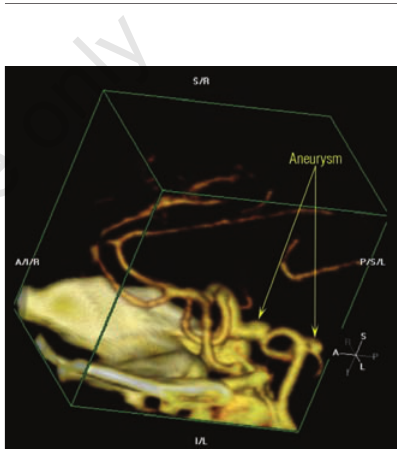
Figure 6. Computed tomography angiog- raphy showing a 6 x 4 mm aneurysm at the right posterior communicating artery and an 8 x 8 mm aneurysm arising from the distal cavernous portion of the right inter- nal carotid artery.